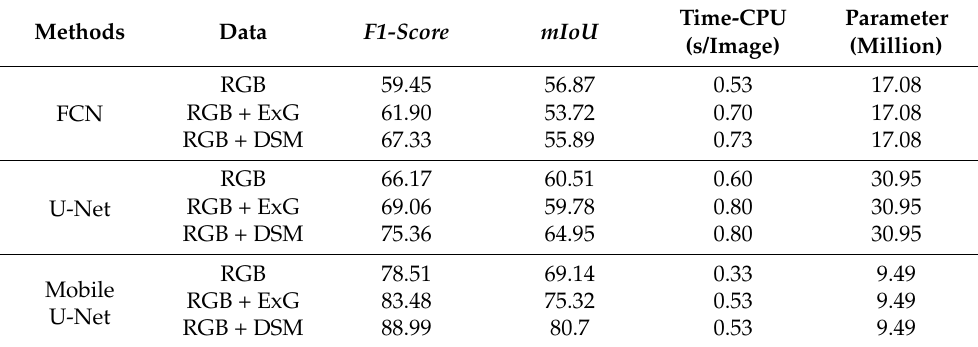
Table 3. Comparison of lodging recognition results of different